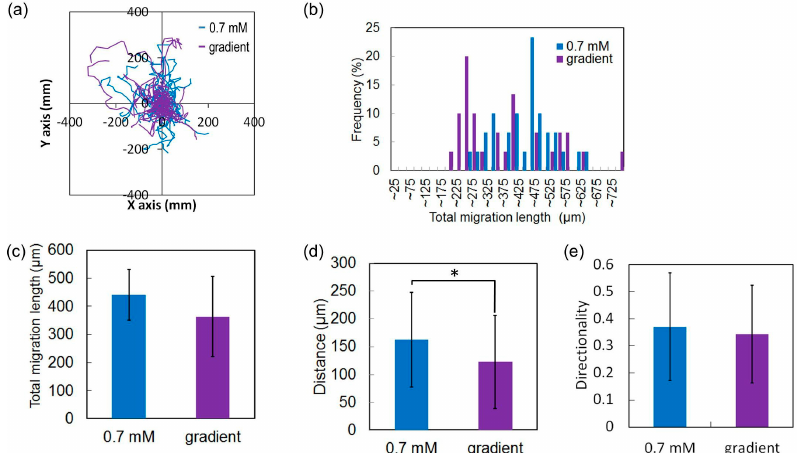
Figure 17. Mobility of HeLa cells in uniform and low gradient concentrations of glucose over a period of 24 h. ( a ) Trajectories of HeLa cells; ( b ) Histogram of the total migration length; ( c ) Average total migration length; ( d ) Travel distance from the origin; ( e ) Directionality of HeLa cells along the y -axis. * p < 0.01 ( t -test).